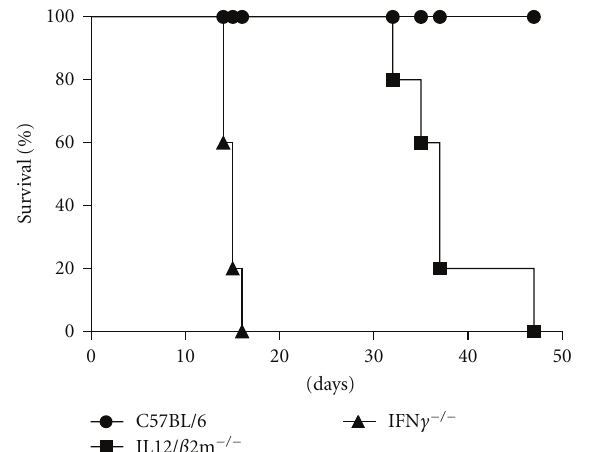
Figure 2: IFN- γ is critical for e ffi cient control of B. abortus in vivo. Groups of 5 mice were injected intraperitoneally with 10 6 CFU of B. abortus S2308. Each mouse strain was monitored daily for survival during 50 days postinfection.